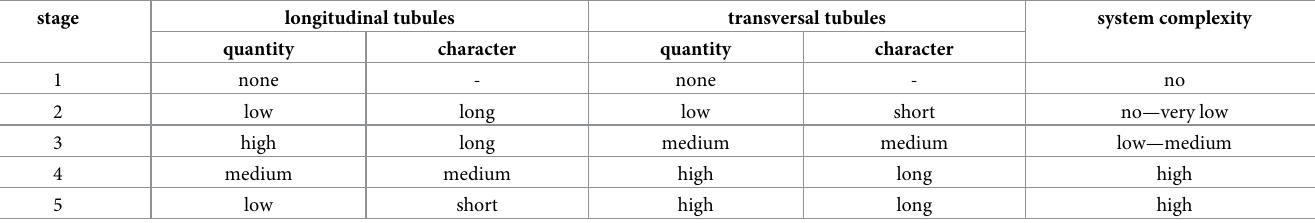
Table 1. Characterization of cardiomyocyte development stages. Experts assess cardiomyocyte development stages according to patterns of longitudinal and transversal tubules, considering their quantity and character, and according to the complexity of the tubular system.